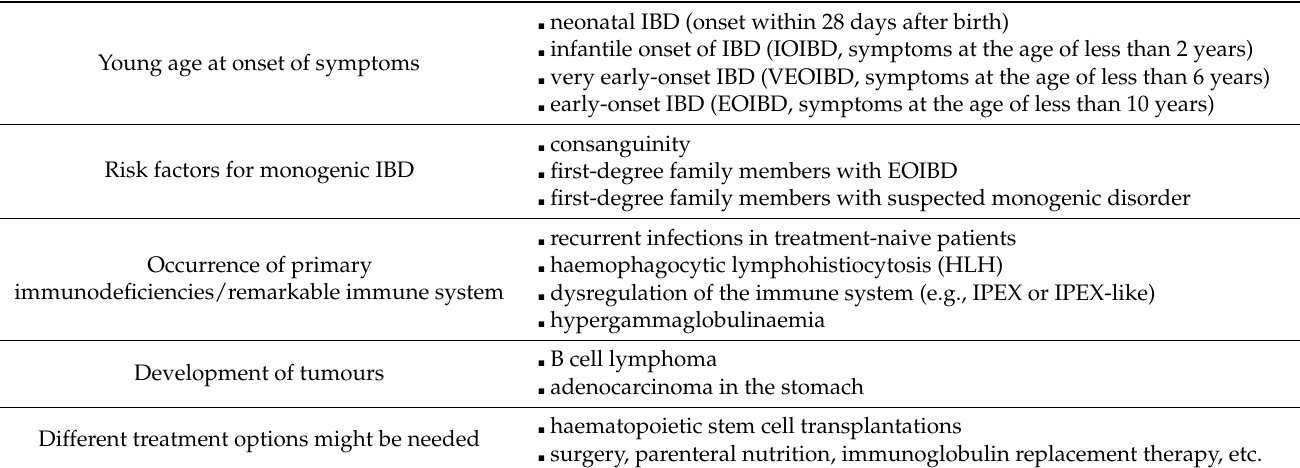
Table 1. Characteristics of monogenic Inflammatory Bowel Disease